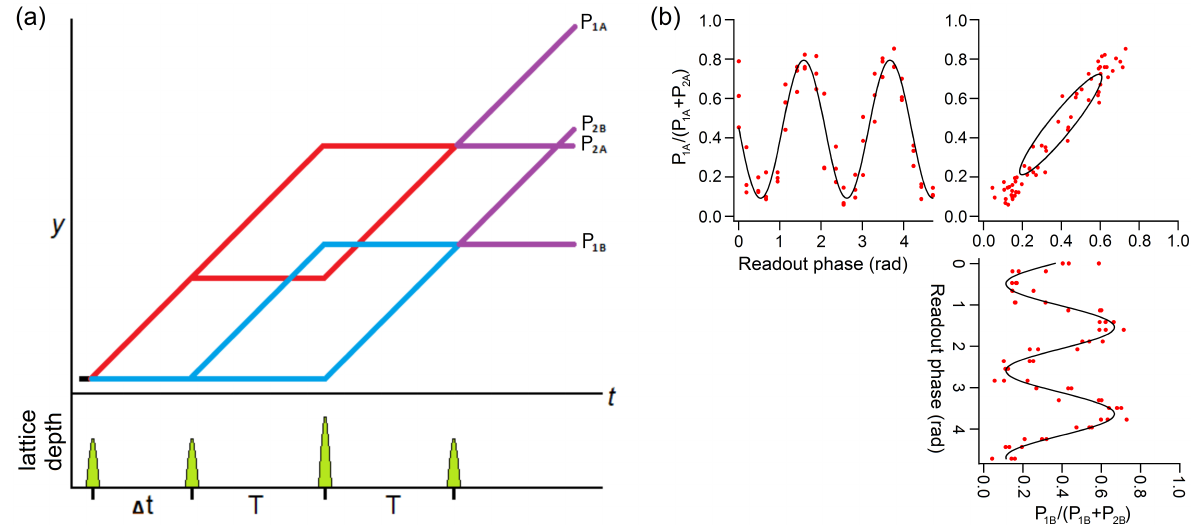
Figure 4. Double Mach–Zehnder interferometry. ( a ) Upper: Space-time diagram for a typical interferometer sequence shown in the accelerating frame of the free-falling BEC source such that the action of gravity is removed. The horizontal lines and the lines with finite slope correspond to interferometer paths separated in momentum by 6¯ hk g . Lower: Corresponding lattice pulse sequence; ( b ) representative ellipse signal for a double Mach–Zehnder interferometer with ∆ t = 3 ms and T = 0.25 ms. The oscillating populations in the output ports are plotted versus the phase of the readout lattice for the two sub-interferometers, from which an ellipse can be observed in the correlation of the populations in the top right parametric plot. All black curves are best fit sinusoids or